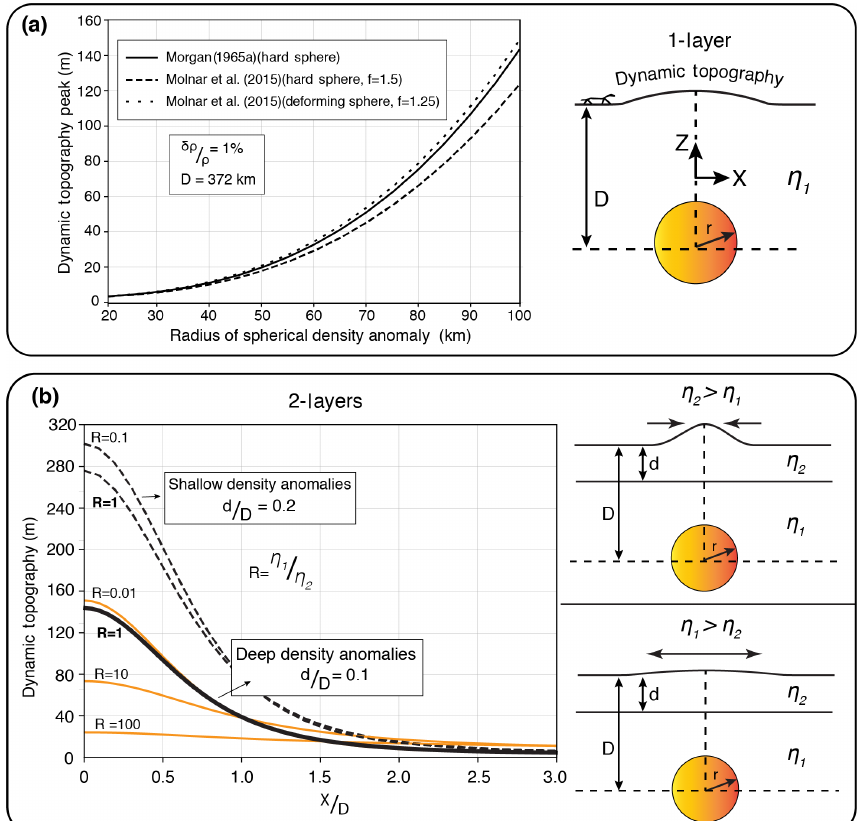
Figure 1. Dynamic topography driven by a spherical density anomaly of radius r at depth D embedded in a fluid whose viscosity structure is varied. (a) Variation in dynamic topography by radius of a spherical 1% density anomaly centred at 372km depth in a single isoviscous fluid whose viscosity is η 1 . The normal total stresses are calculated by Eq. (1) taken from Morgan (1965a) (hard sphere) and Eq. (3) taken from Molnar et al. (2015) (hard and deforming spheres), and converted to dynamic topography by using Eq. (2). (b) The case where the fluid is no longer a single layer but is composed of two layers with viscosities η 1 and η 2 for the lower and upper layers, respectively. We plot the dynamic topography for the same density anomaly in (a) using Eq. (4), taken from Morgan (1965a), but with varying relative viscosities ( R = η 1 /η 2 ). The ratio of upper-layer thickness to depth to the centre of the anomaly ( d/D ) also affects the dynamic topography, and higher values correspond to shallow density anomalies or thicker lithosphere for constant depth ( D